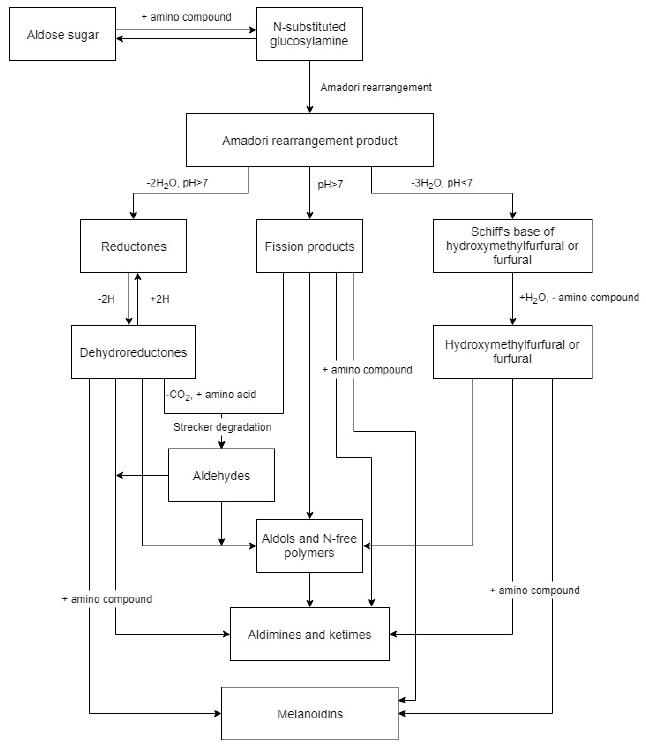
Figure 1. General scheme of the Maillard reactions leading to the generation of